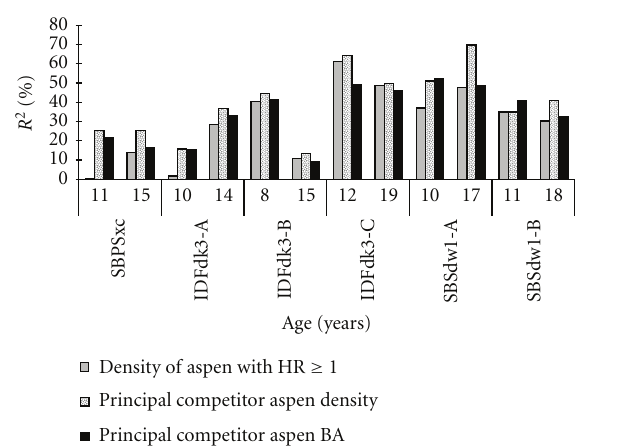
Figure 3: Comparison of R 2 values for models predicting 2–5-year pine diameter growth from (a) the density of aspen with aspen/pine height ratio ≥ 1.0, (b) principal competitor aspen density, or (c) principal competitor basal area.